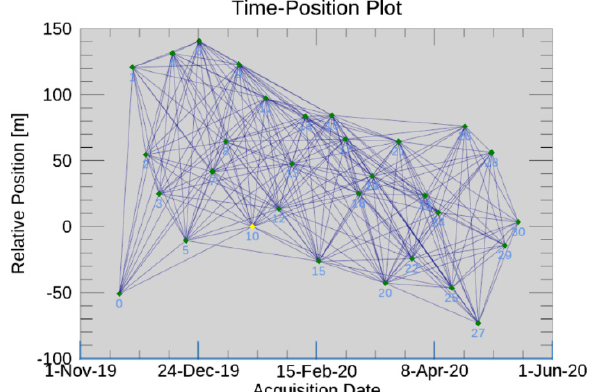
Figure 5. Normal and temporal baselines of connected image pairs in SBAS processing.